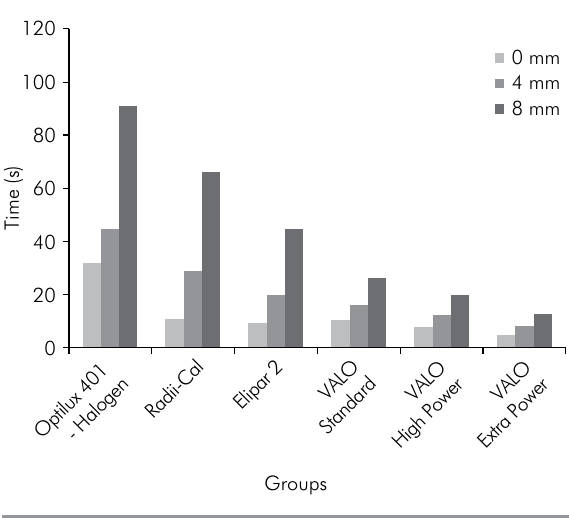
Figure 2. Mean time required to achieve an energy density of 16 J/cm 2 at each emission distance from the tip to the sensor.